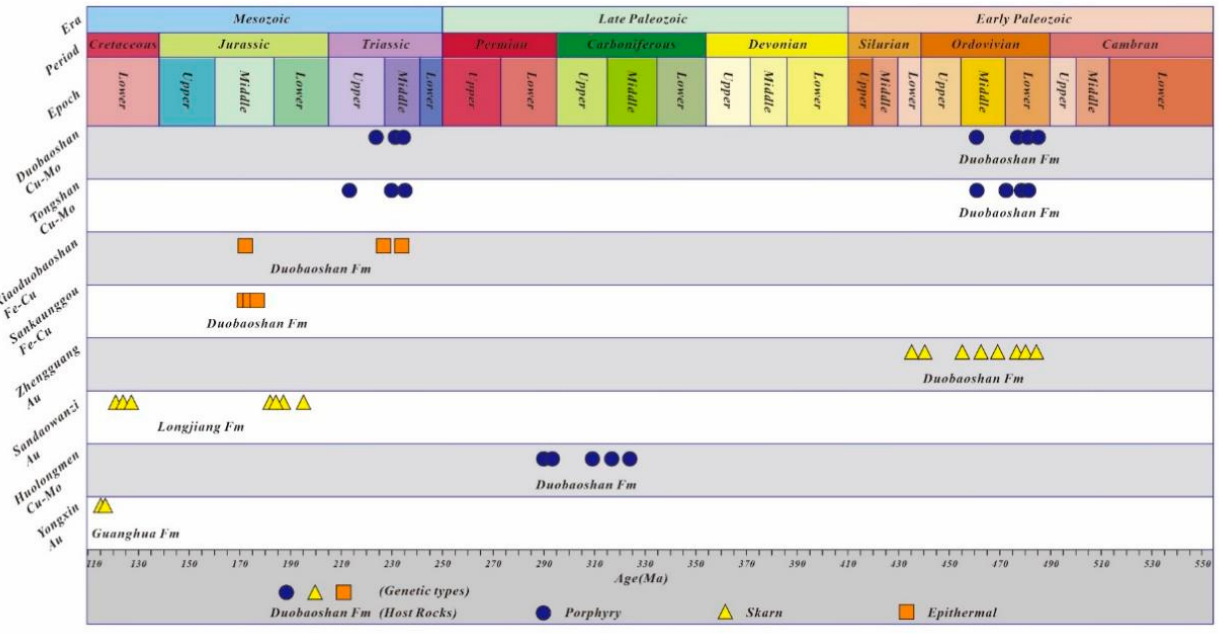
( B ) Regional geological map of the Duobaoshan ore district and adjacent regions.